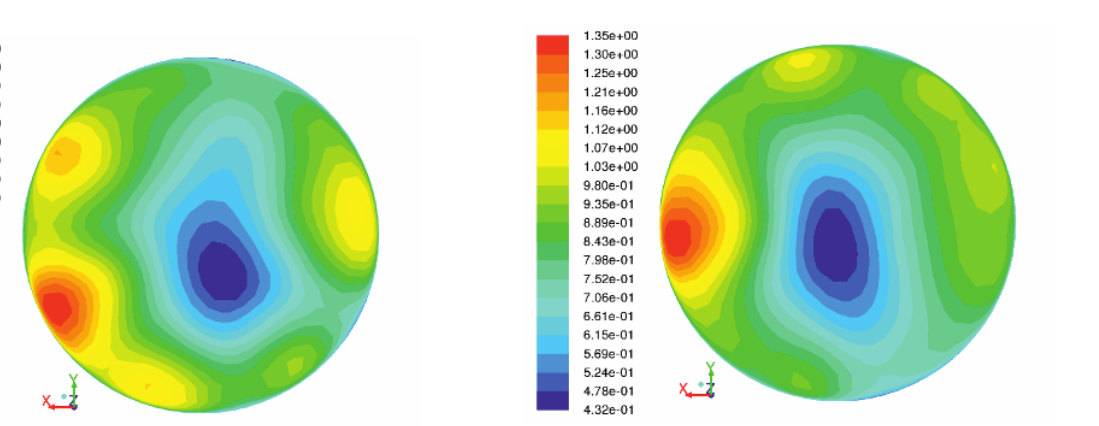
Figure 18: Average velocity distribution in metering run #1